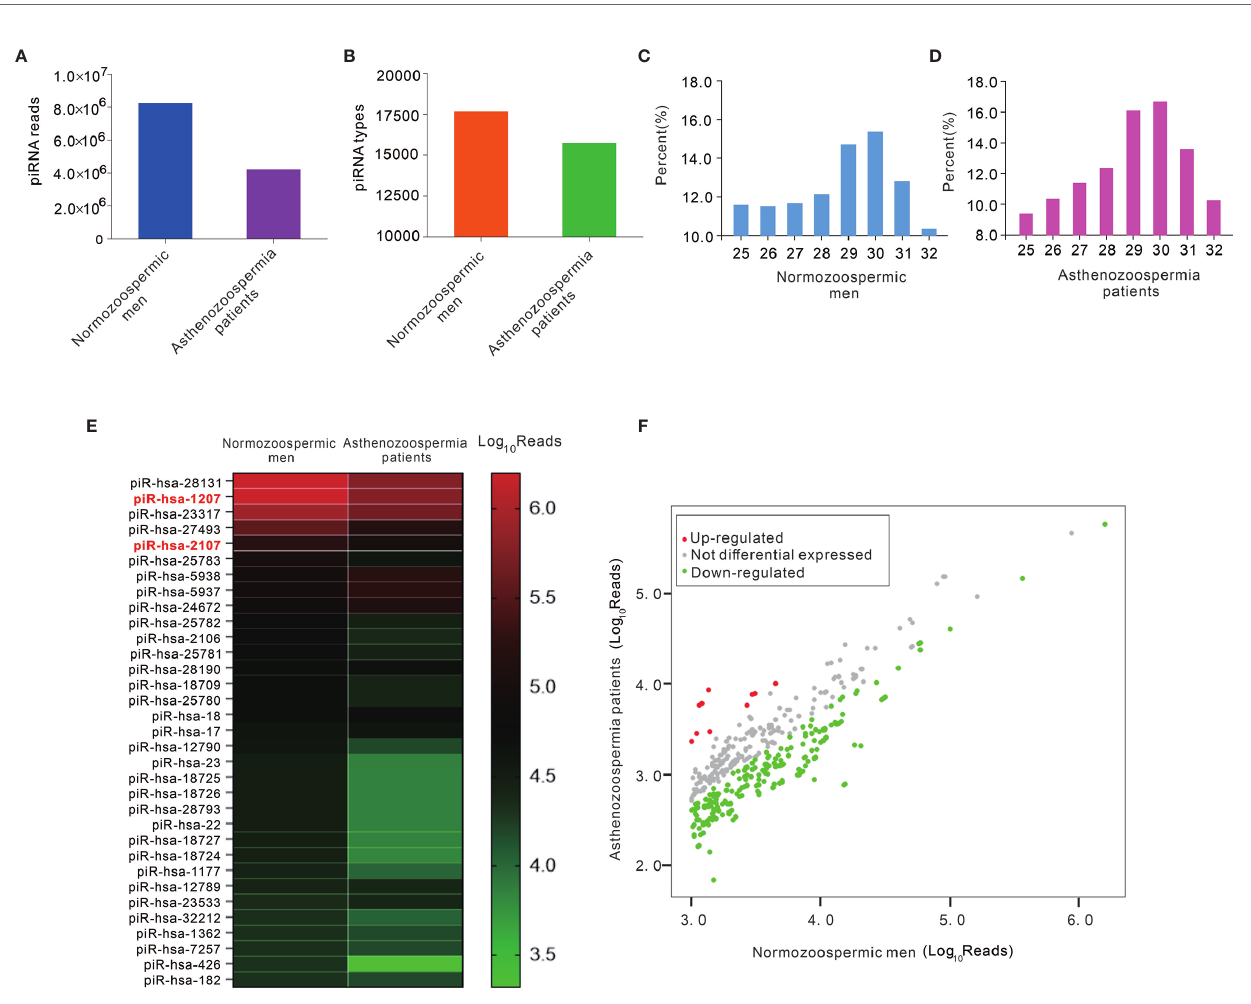
FIGURE 3 | The analysis of high-throughput sequencing of piRNAs in sperms from asthenozoospermia patients and normozoospermic men. (A, B) Total sequencing reads (A) and types (B) of piRNAs were decreased in sperms of asthenozoospermia patients compared with those in normozoospermic men. (C, D) The distribution of small RNAs of various lengths (25-32 bp) measured by high-throughput sequencing in sperms. (E, F) The heatmap (E) and scatter plots (F) analysis of sequencing reads of piRNAs between asthenozoospermia patients and normozoospermic